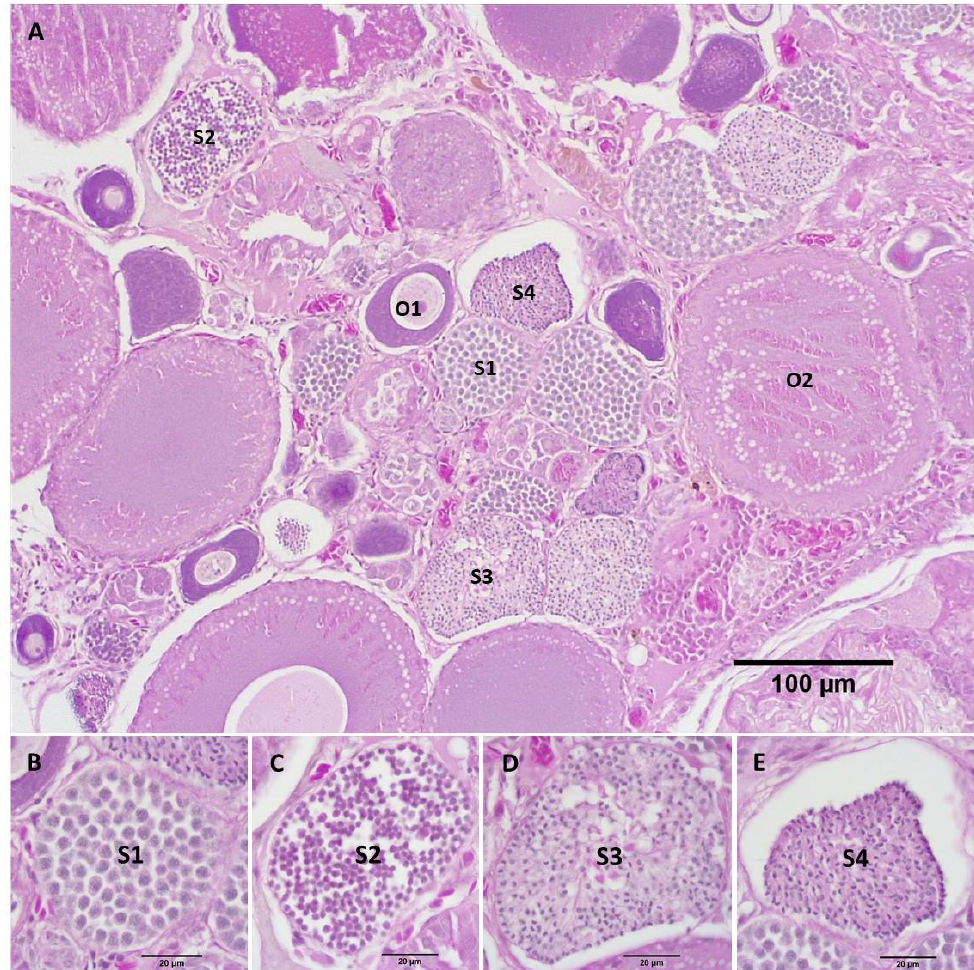
Figure 7. Sagittal sections through the gonad of a RG female fed with the 200 mg MT/kg diet. ( A ) The gonad presented several stages of follicular development from primary oocytes (O1) to cortical alveoli oocytes (O2) and various stages of spermatogenesis from primary spermatocytes (S1), secondary spermatocytes (S2) to early (S3) and late (S4) stages of spermatid. ( B – E ) The structures of S1, S2, S3, S4 at higher magnification, respectively. Table 1. Total gonad and testicular tissue areas of RG females treated with MT for a 50-day period ( n = 1 fish/treatment).